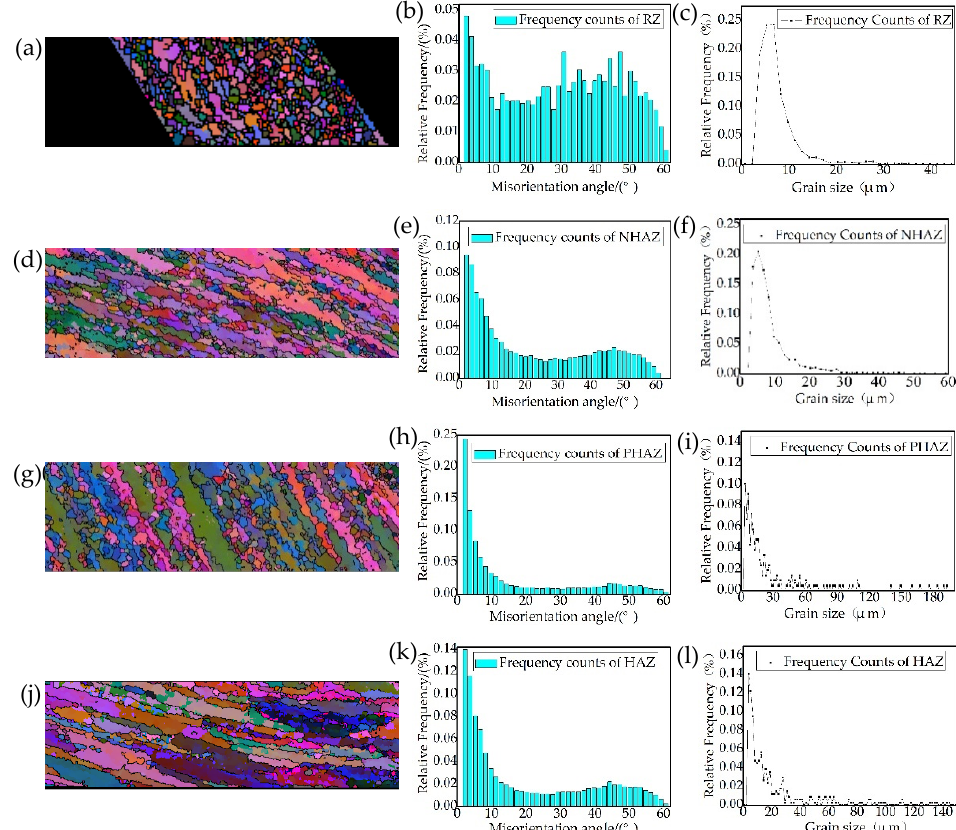
(Figure 15c,f,i,l), in RZ and NHAZ, grain diameters concentrated in 2–15 μ m. In HAZ and PHAZ, grain with diameters ranged from 2 to 60 μ m approximately.